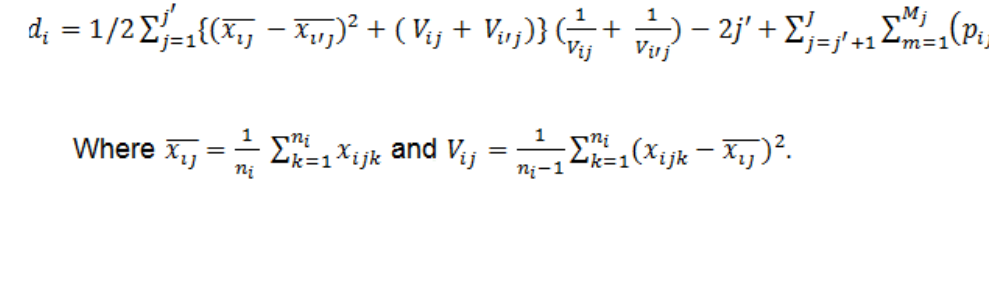
Figure 4. Equation for the KLD